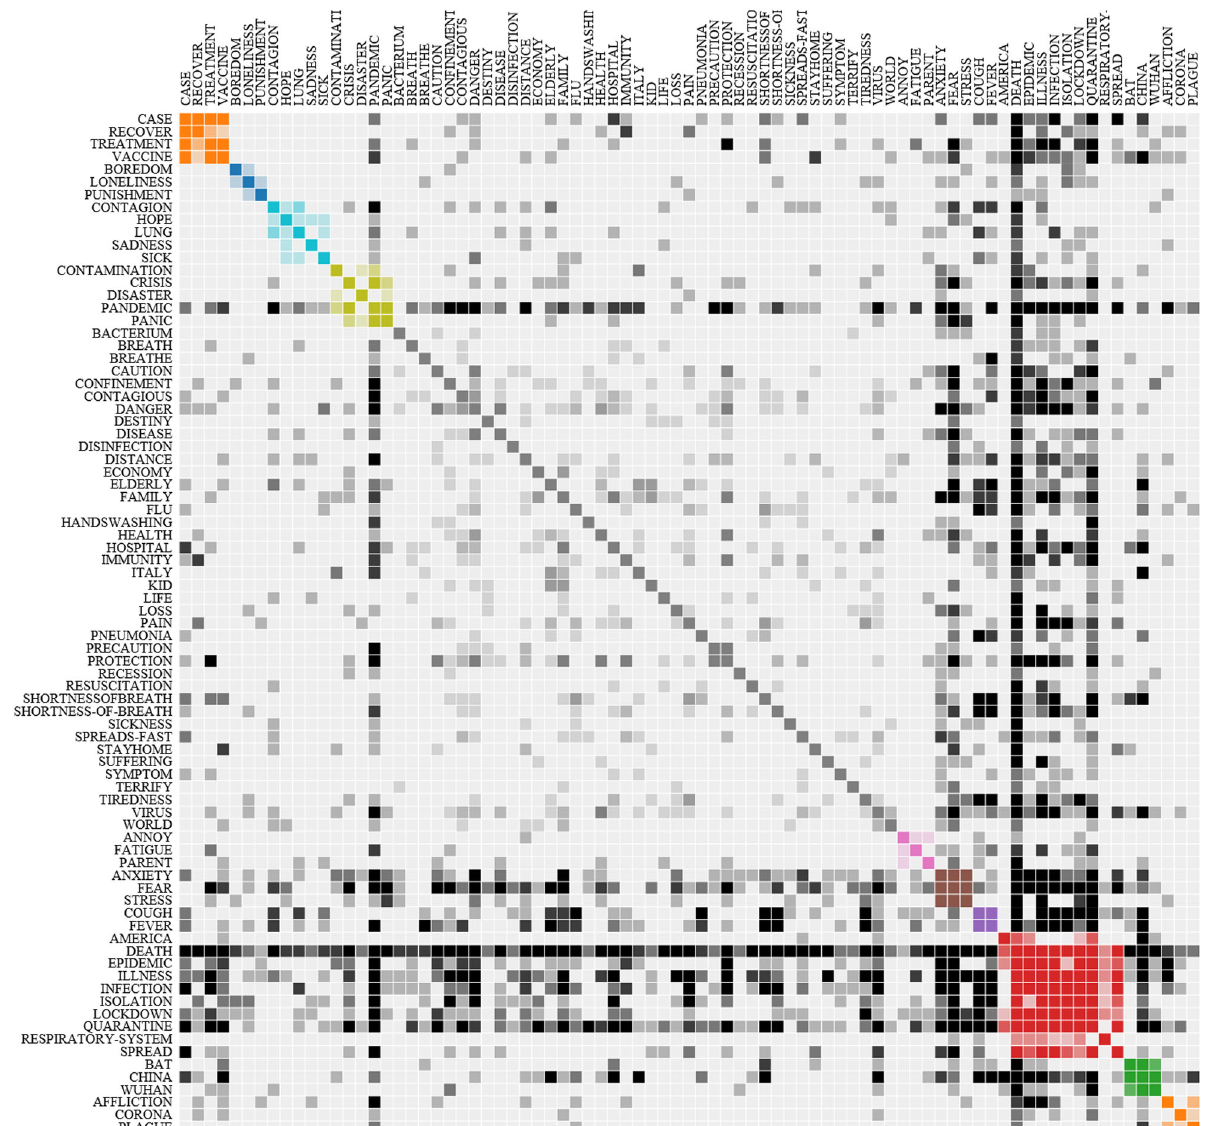
Fig. 3 The co-occurence matrix. Graphical representation of within n-grams word co-occurrences matrix (speci fi cally bi-grams). Different colors indicate clusters; Color shades stand for weights; Values are word co-occurrences.